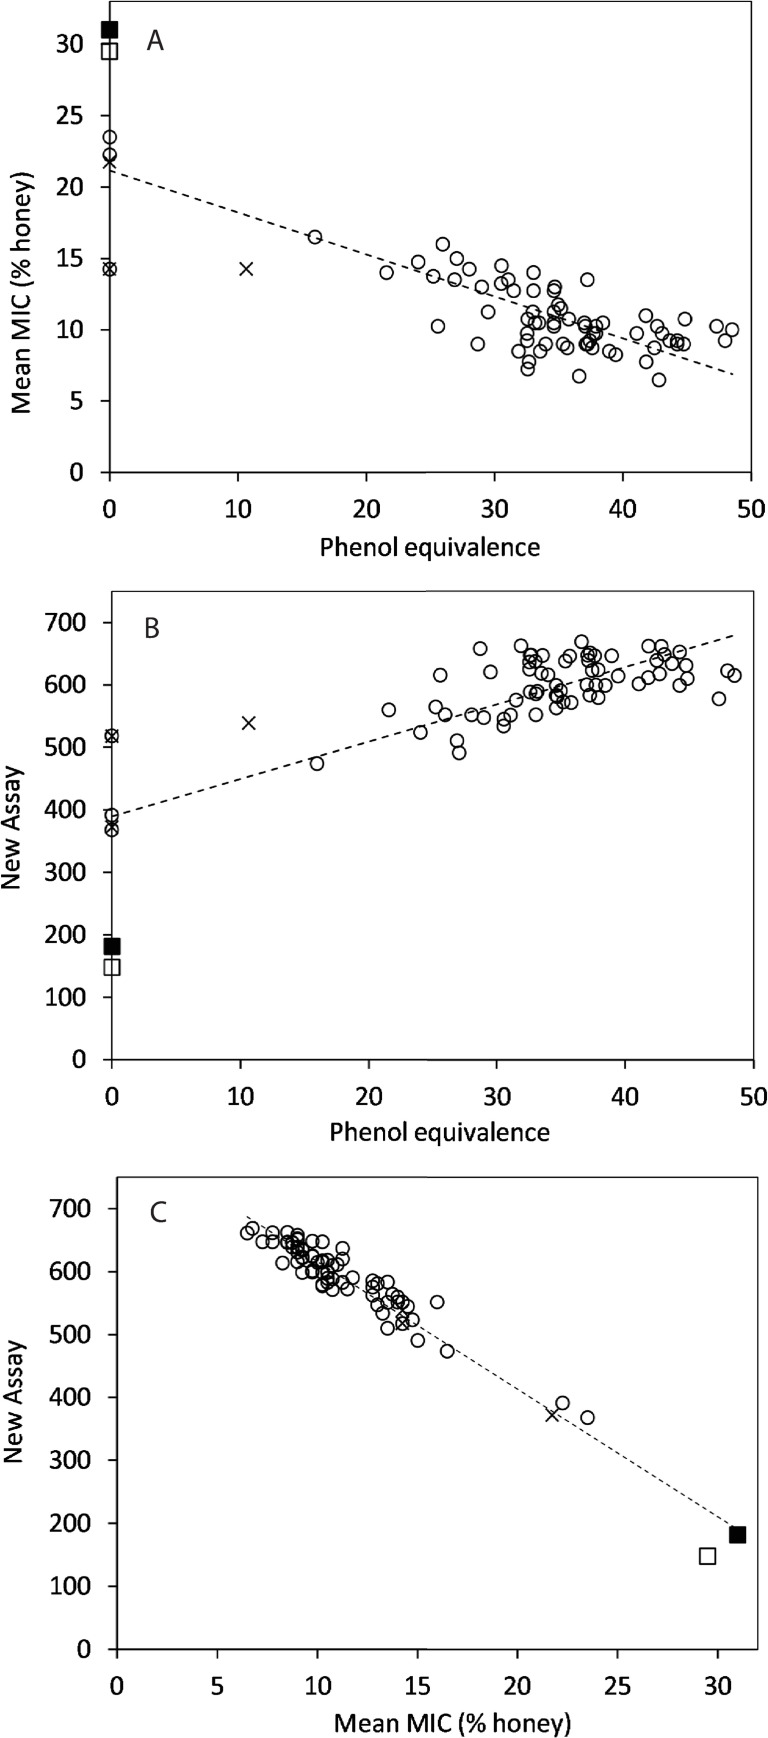
Correlation of antibacterial activity measurements.Scatter plots show correlation between (A) Phenol equivalence and mean MIC values; R2 = 0.649, (B) Phenol equivalence and new antibacterial activity values; R2 = 0.620 and (C) mean MIC and new antibacterial activity values; R2 = 0.949. The open circles represent blinded samples and Jarrah and Marri controls, cross symbol denotes Leptospermum honeys, open square represents the multifloral honey and the black square represents artificial honey.